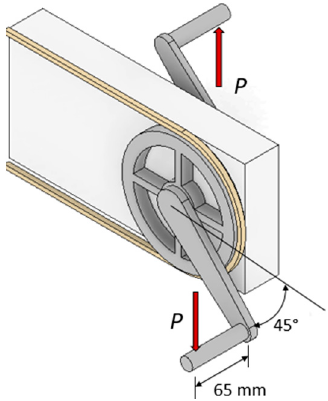
Figure 5. Bicycle crank test conditions according to EN 14781:2006 [7].